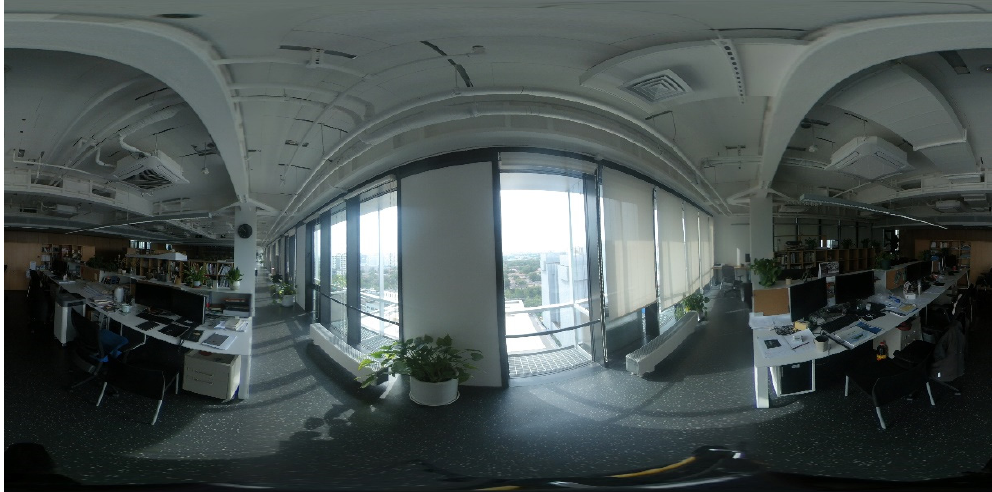
Figure 1. The panoramic view of an open-plan office.